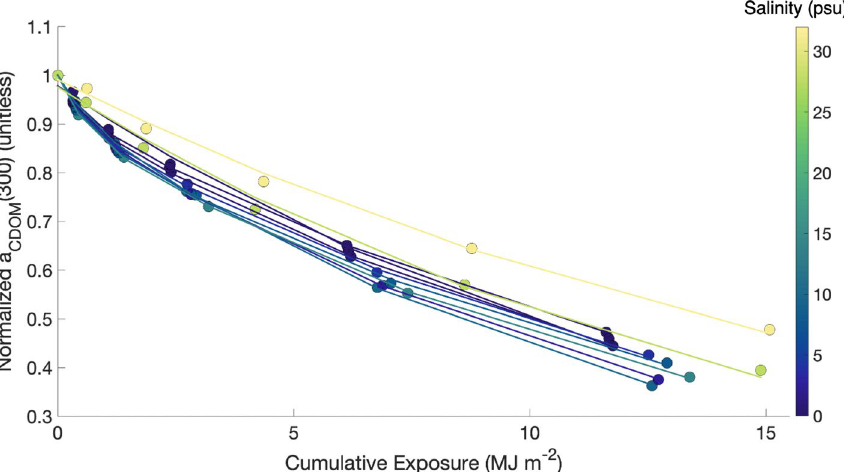
Figure 1. Mean observed (colored circles) and modeled (solid line) photochemical loss of a CDOM (300) for each station, normalized to the initial a CDOM (300) value for scaling purposes. Marker and line color indicates the mean salinity observed in the upper 1 m of the water column at each station. Photochemical loss of CDOM was modeled with a single exponential for stations 10, 12 and 24, and a double-exponential for all other stations (Table S1). Peak absolute loss of absorption occurred between 290 and 305 nm for all stations and time